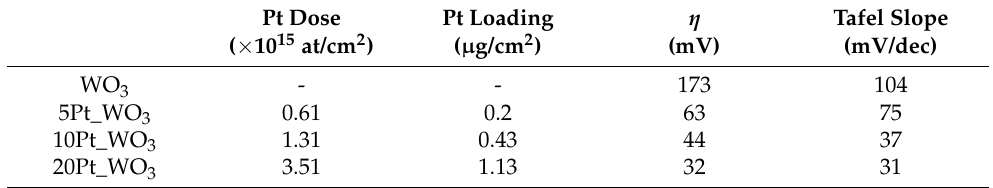
Table 1. Pt dose obtained from RBS analysis and Pt loading for the Pt-decorated WO 3 -based elec- trodes, η , and Tafel slope of the WO 3 , the 5Pt_WO 3 , the 10Pt_WO 3, and the 20Pt_WO 3 electrodes. Pt Dose Pt Loading η ( × 10 15 at/cm 2 ) ( µ g/cm 2 ) (mV) WO 3